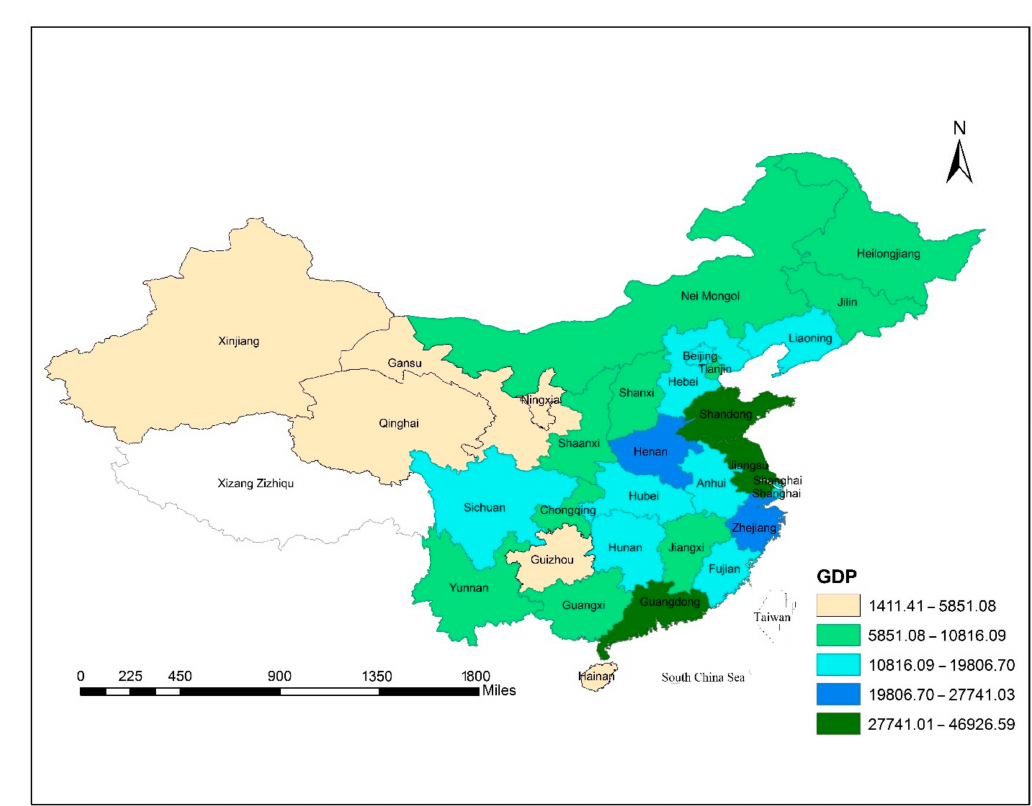
Figure 2. The spatial distribution of GDP per capita in China provinces from 2001 to 2018.